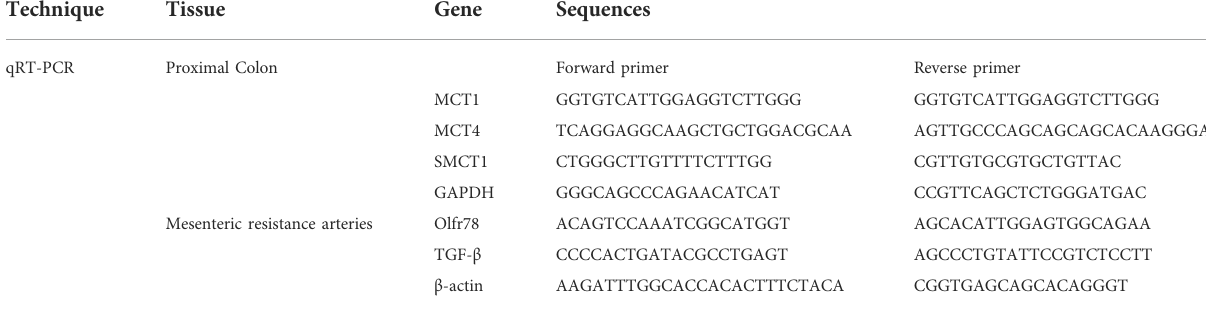
TABLE 1 Primer sequences used on qRT-PCR for analysis of proximal colon and mesenteric arteries. Technique